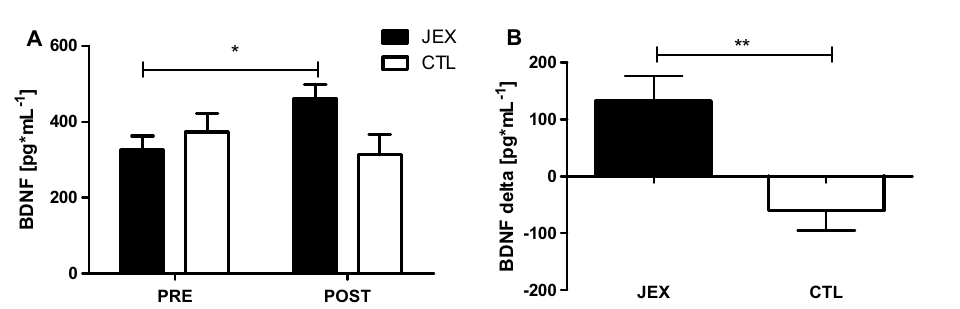
Figure 1. The effect of JEX on the peripheral BDNF concentration ( A ); and the contrast between the JEX delta (post–pre) and CTL delta (post–pre) ( B ). The values represent the mean. The error bars indicate the standard error of the mean. JEX pre vs. post-intervention *p < 0.01 post hoc Bonferroni test ( A ), contrast between the JEX delta and CTL delta **p < 0.001 Mann–Whitney U test ( B ).